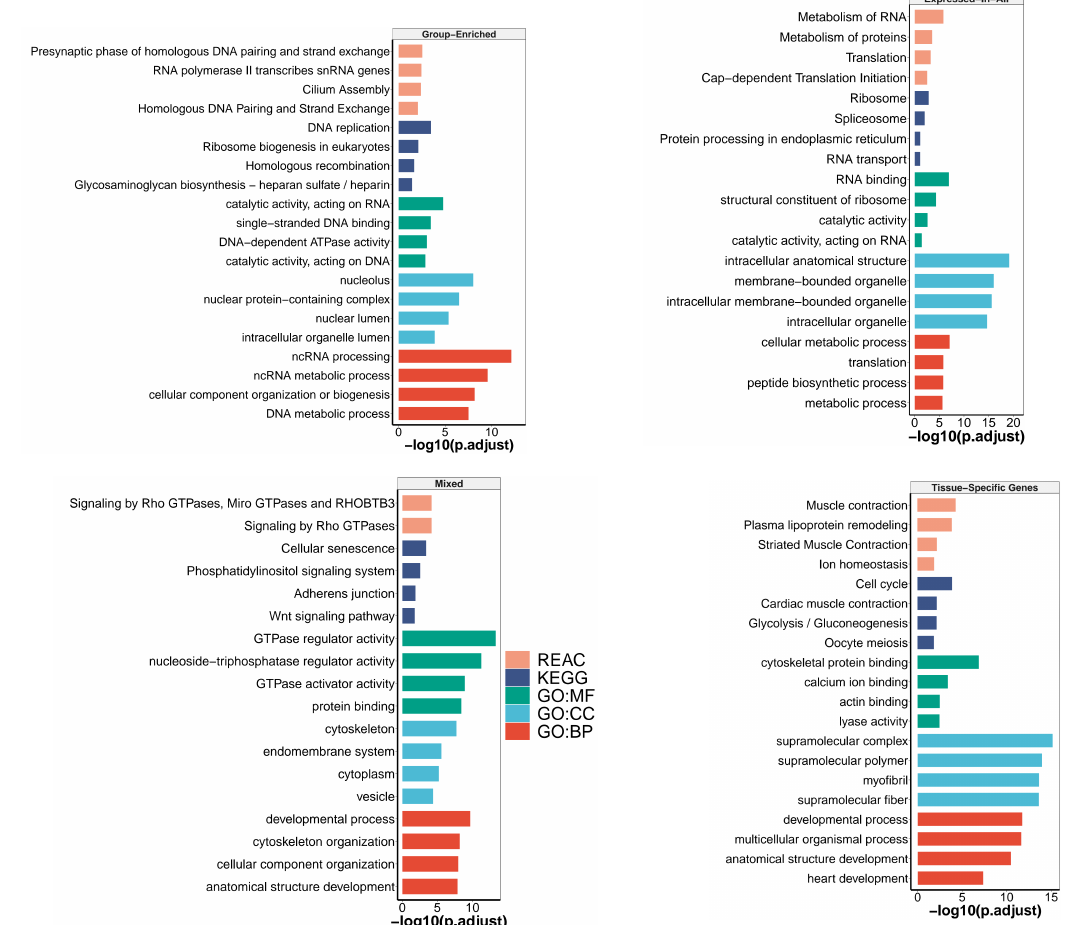
Figure 3. Enrichment of Gene Ontology (GO) terms, KEGG and Reactome (REAC) pathways for each genes class. The top 4 significant (FDR < 0.05) GO terms/functional pathways are depicted here, including REAC (Reactome Pathways), KEGG (KEGG Pathways), GO:BP (Biological Process), GO:CC (Cellular Component), and GO:MF (Molecular